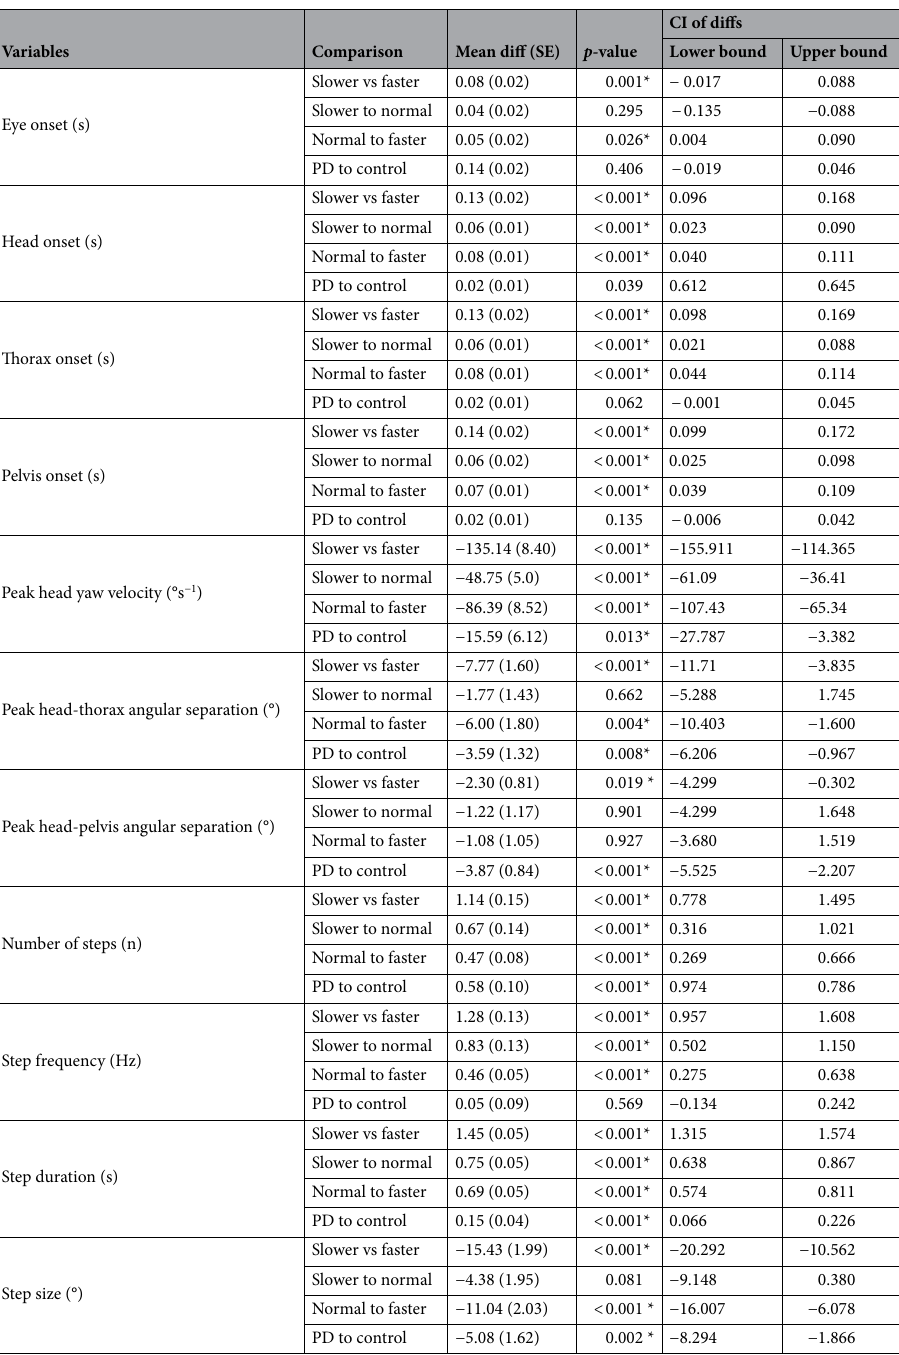
Table 3. Post hoc comparisons for the main effects of groups and turning speeds as shown by the mixed model analysis of variance, where no interactions were indicated. Diff difference, CI confidence intervals, PD Parkinson’s disease. *Significant difference ( p < 0.05) from mixed model analysis of